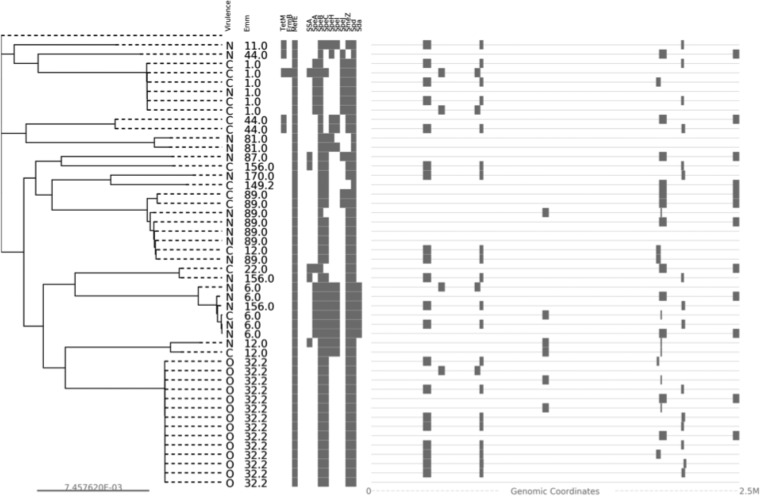
Maximum likelihood phylogeny of the 48 GAS isolates based on core genome SNPs. Each branch is annotated with isolate source followed by the in silico emm type. R, the GAS reference sequence Streptococcus pyogenes HKU16; C, control iGAS cases; N, control noninvasive isolates; and O, outbreak emm32.2 iGAS cases. (Middle) Antibiotic resistance and superantigen genes (in gray) in the genomes of the study isolates. (Right) Predicted genomic locations of putative prophage elements in each study isolate.